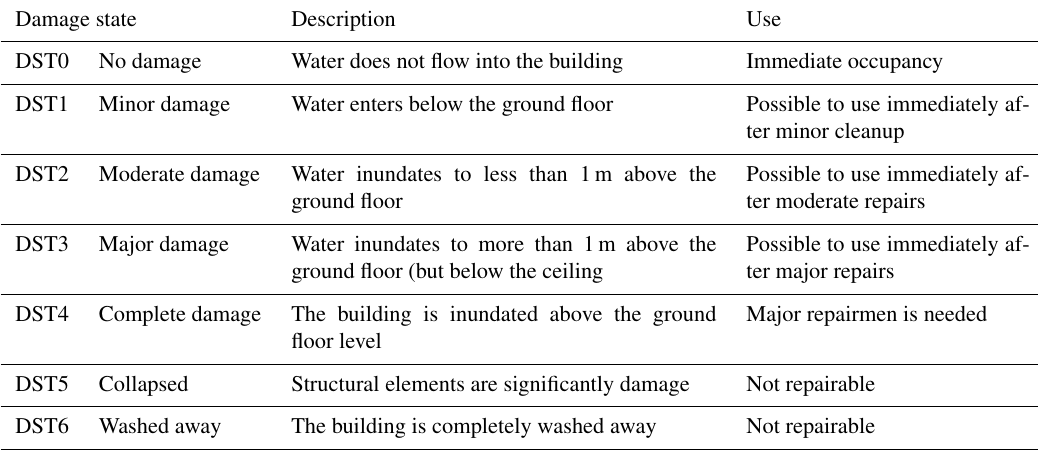
Table 4. Damage state definitions for tsunami (Suppasri et al., 2014; Charvet et al., 2017). Damage state